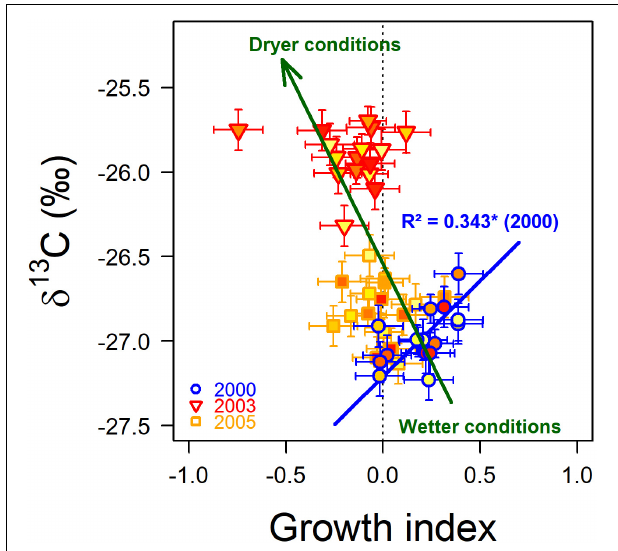
FIGURE 6 | Correlation between the least-square means of δ 13 C and growth index (GI) in 2000 (blue circles), 2003 (red triangles), and 2005 (orange squares). The error bars represent the standard error of the mean. The blue line indicates the significant among-population relationship between the two traits in 2000 ( n = 16) with its coefficient of determination ( R 2 ) and significance level (*: 0.01 < p < 0.05). The green arrow represents the direction of δ 13 C and growth index variations in response to drought. The type II regression between the two traits in 2003 and 2005 is not shown because not significant. Symbol fill colors indicate the average water deficit index (dimensionless) calculated over the 1960 – 1999 period ( Figures 1 , 3